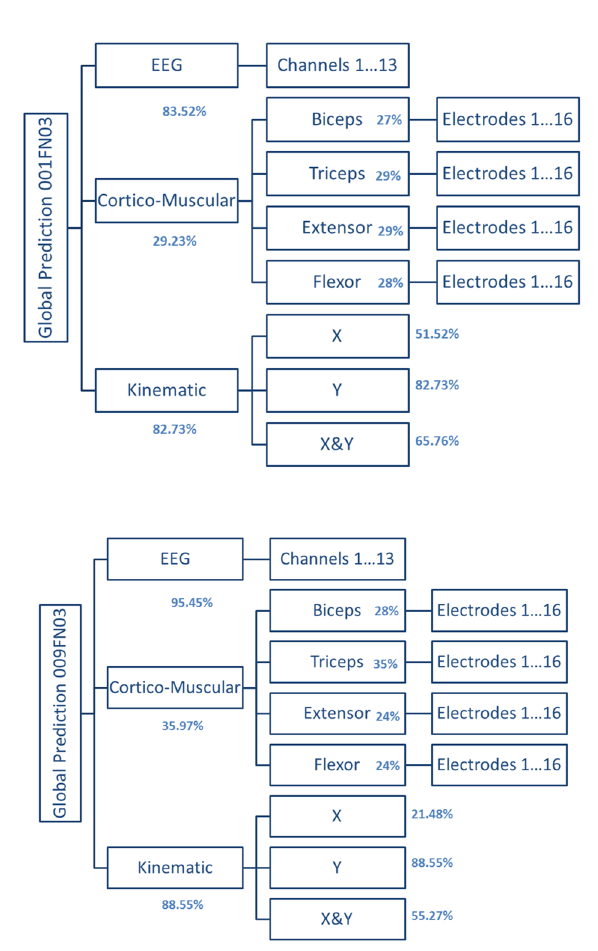
Figure 9. Example of probability tree from patients 001 and 009 (trials FN003). EEG QPs and the probabilities of stimulation for the kinematic and the cortico-muscular modules are visualized in a tree form. For each leaf of the tree, a parameter of prediction can be computed. Values are given in %. Once the tree is filled, it is possible to identify the best parameters and associate them.